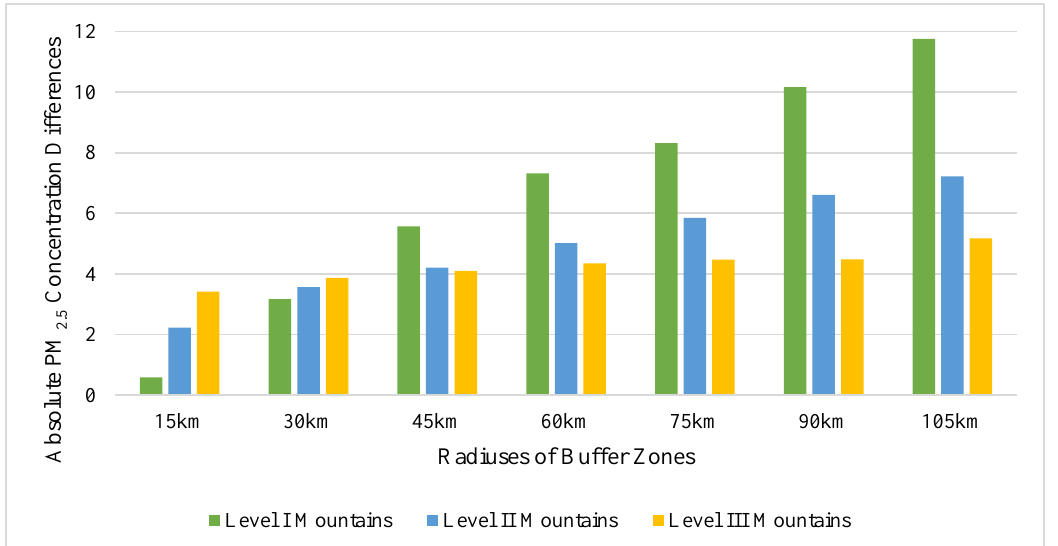
Figure 7. The absolute PM 2.5 concentration differences between the two sides of Level I–III mountains at different buffer zones. We first averaged the PM 2.5 concentration pixels within the 15 km buffer zones of the two sides of the Level I mountains; then, the absolute value of the difference between the two average PM 2.5 concentrations was calculated. The results for other buffer zones were found analogously.